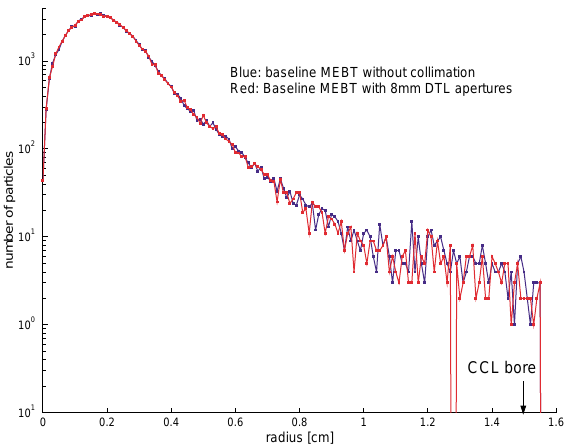
FIG. 19. (Color) Radial beam distribution at 171 MeV with and without DTL collimation. Apertures of 6 mm radius reduce beam halo by 90%, but result in excessive drift tube